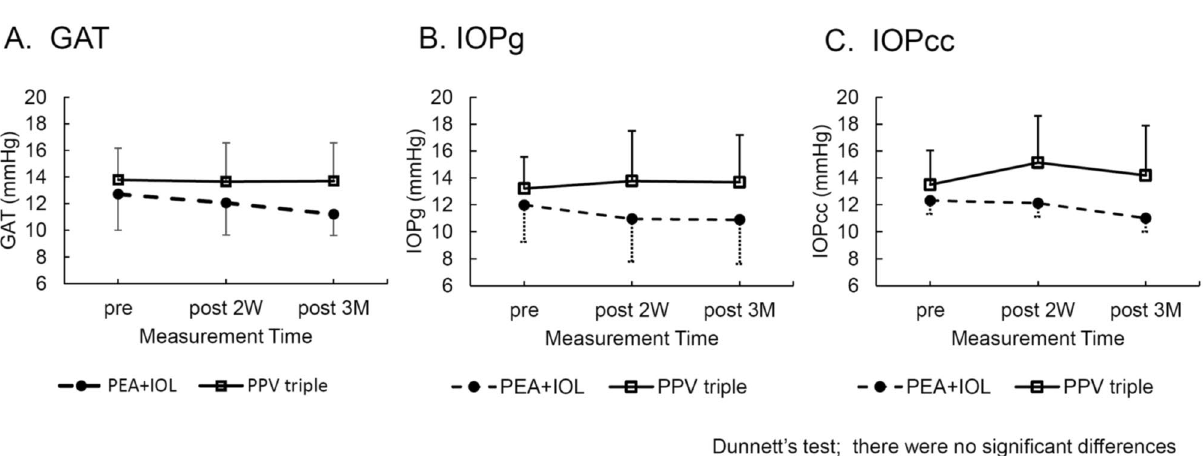
Figure 2. The Goldmann applanation tonometry (GAT) ( A ) (preoperatively, 2 weeks, and 3 months after surgery) of the PEA + IOL group was 12.7 ± 2.7, 12.1 ± 2.4 and 11.2 ± 1.6 mmHg, and PPV triple group was 13.8 ± 2.4, 13.7 ± 2.9 and 13.7 ± 2.9 mmHg. The IOPcc ( B ) of PEA + IOL group was 12.3 ± 2.6, 12.1 ± 2.6, and 11.0 ± 1.1 mmHg, and PPV triple group was 13.5 ± 2.6, 15.1 ± 3.4, and 14.2 ± 3.7 mmHg preoperatively, 2 weeks, and 3 months after surgery. The IOPg ( C ) PEA + IOL group was 12.0 ± 2.8, 11.0 ± 3.1, and 10.9 ± 3.3 mmHg, PPV triple group was 13.2 ± 2.4, 13.8 ± 3.7, and 13.7 ± 3.5 mmHg, preoperatively, 2 weeks, and 3 months after surgery, respectively. There was no significant difference in postoperative compared to preoperative IOP in both groups (p > correlations preoperatively (r = 0.555; p = 0.003), which disappeared at 2 weeks (r = 0.322; p = 0.084) and 3 months (r = 0.364; p = 0.058), after surgery. The correlation between preoperative ACD, AL, and CH was not statistically significant at all measurement points for both the PEA + IOL and PPV triple groups (data not shown).